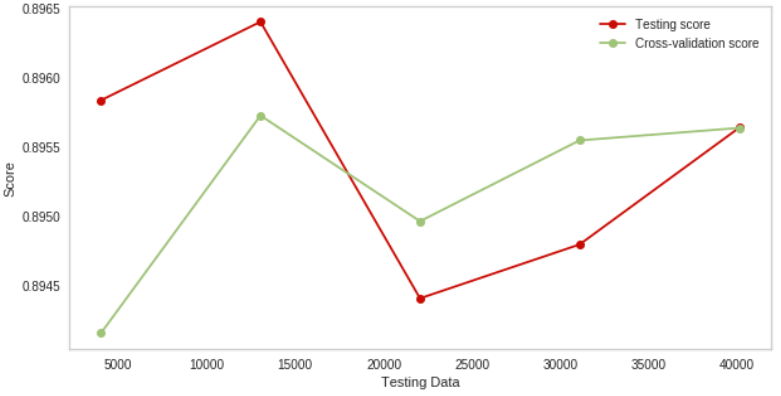
Figure 24. Binary class logistic regression testing and validation learning